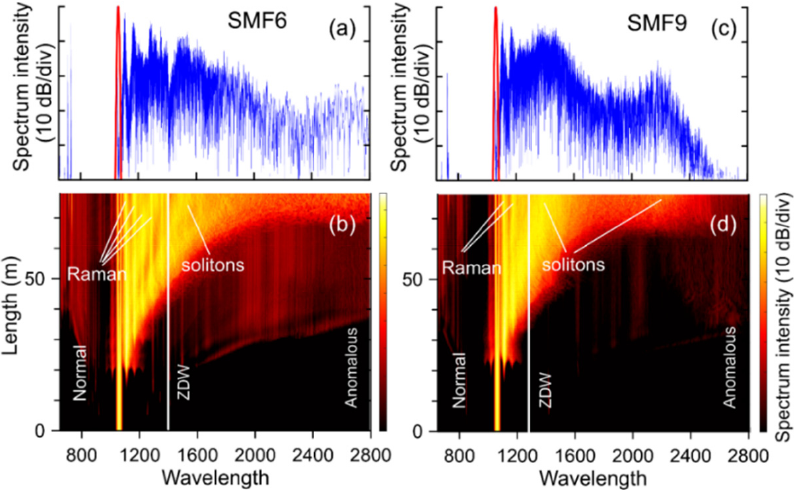
Figure 5. Input (red) and output (blue lines) spectra from ( a ) SMF6 and ( c ) SMF9 fibers. The evolution of the spectral density during the propagation of radiation along the fiber SMF6 ( b ) and SMF9 ( d ). Ultrashort soliton pulses with a peak power of several kilowatts are formed from a part of the radiation that has crossed the wavelength of zero dispersion (ZDW) and passed